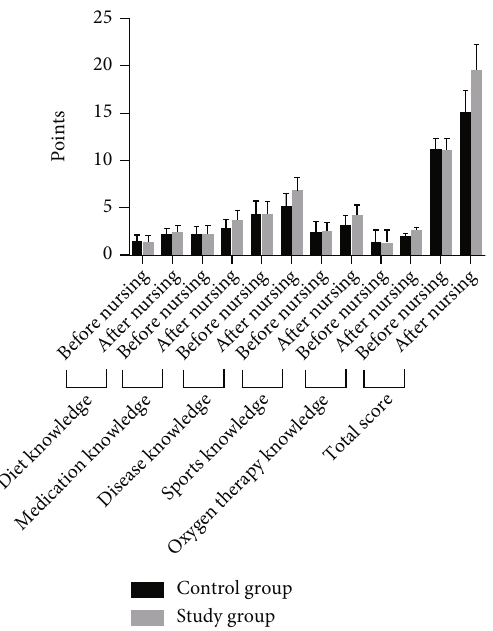
Figure 4: Histogram comparing the knowledge scores of pulmonary rehabilitation between the two